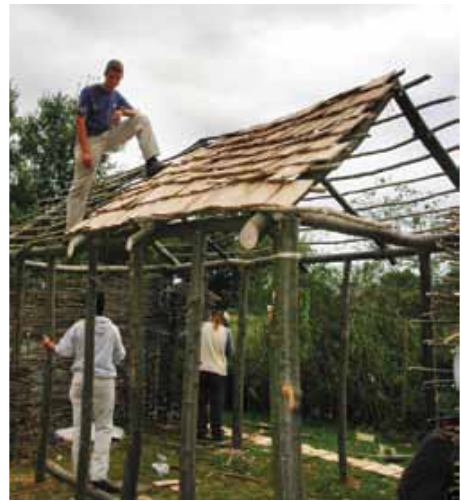
Fig. 2: Building a medieval house on the Experimental Archaeology